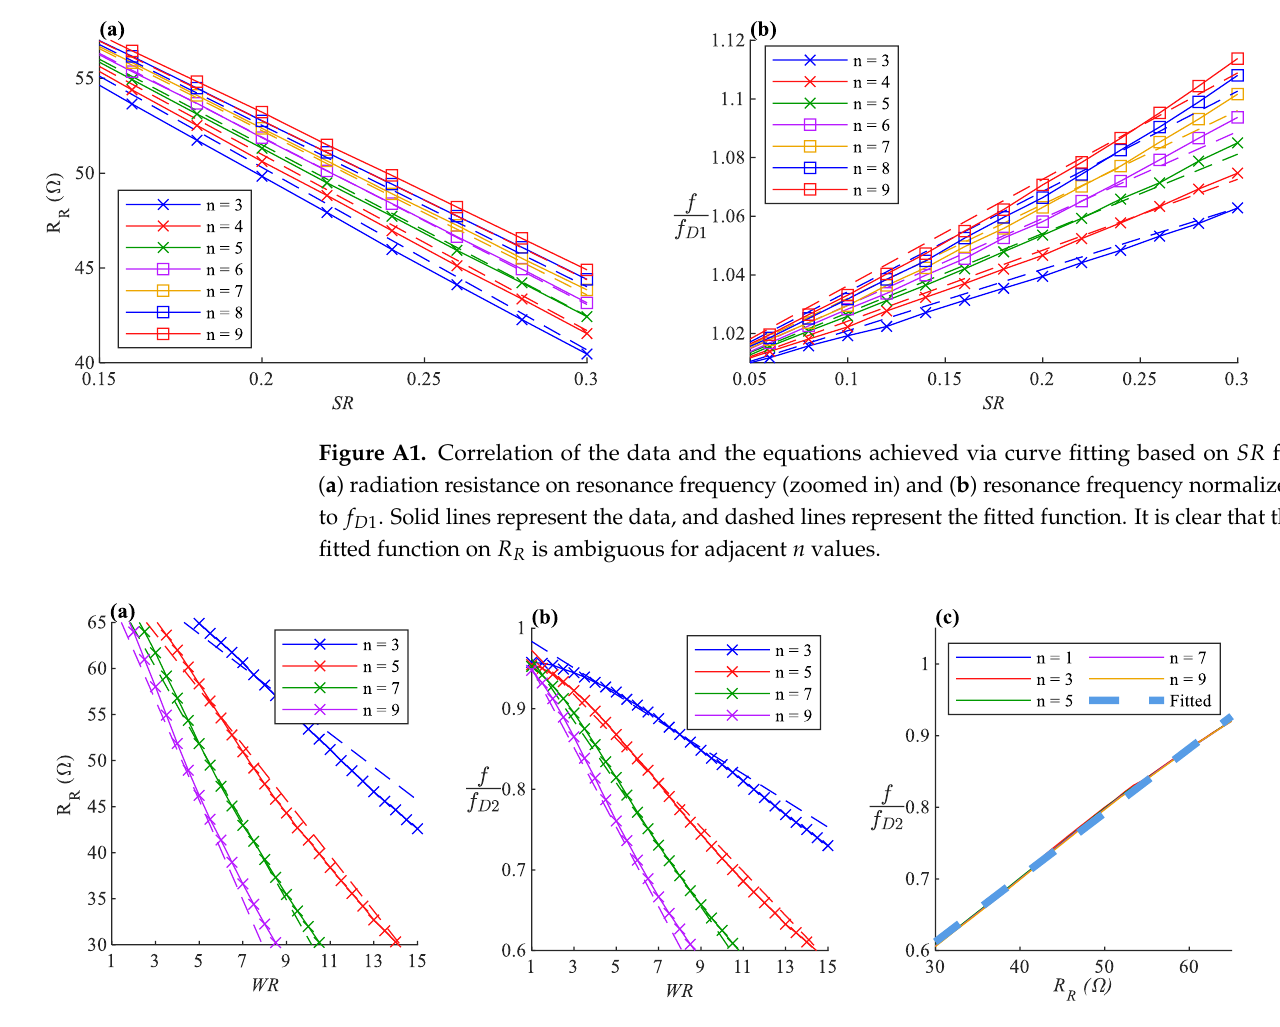
Figure A2. Correlation of the data and the equations achieved via curve fitting based on 𝑊𝑅 for ( a ) radiation resistance on resonance frequency and ( b ) resonance frequency normalized to 𝑓 𝐷2 . Solid lines represent the data, and dashed lines represent the fitted function. ( c ) Correlation of the data and Equation (10), it is evident that the data are almost independent of 𝑛 factor. The dashed line shows the fitted Equation.